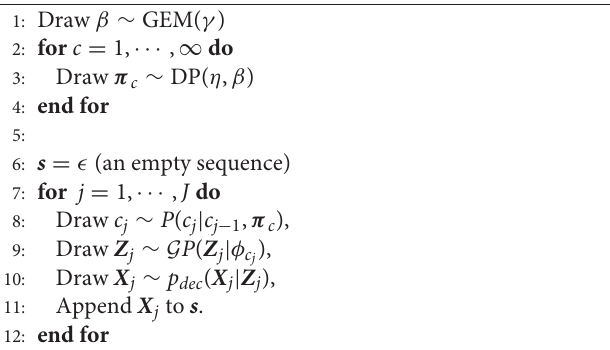
Algorithm 1: Generative process of s by